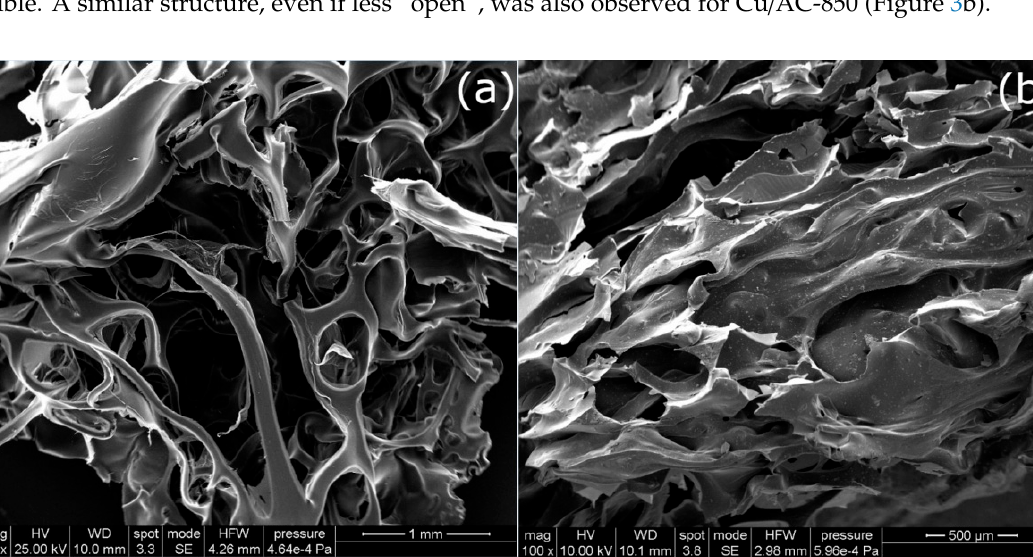
/ AC-850 ( a ) and Cu / AC-850 ( b Figure 3. SEM images of Zn/AC-850 ( a ) and Cu/AC-850 ( b ). Figure 3. SEM images of Zn